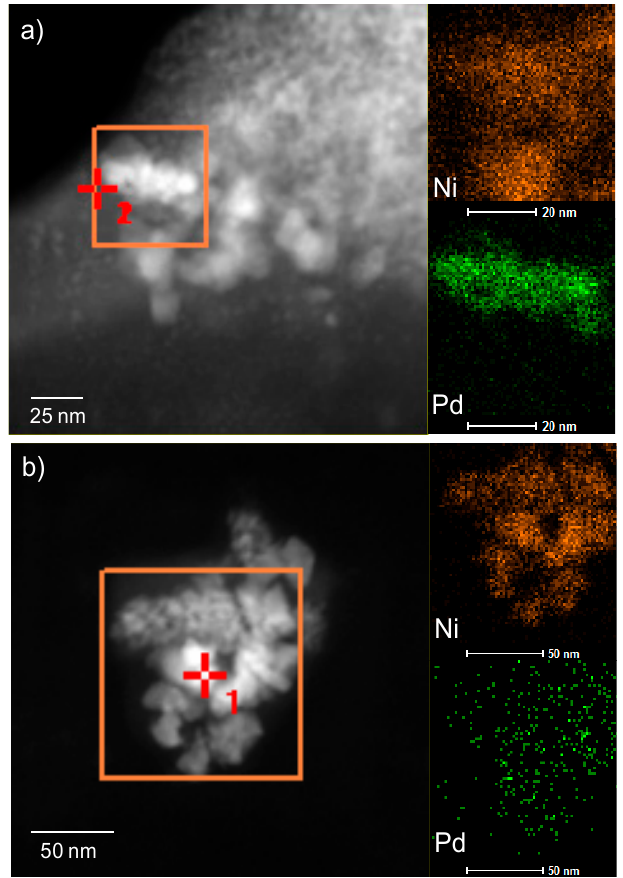
Figure 4. STEM images and elemental mapping for ( a ) NiPd 0.05 TSNH 2 and ( b ) NiPd 0.13 TSNH 2 .